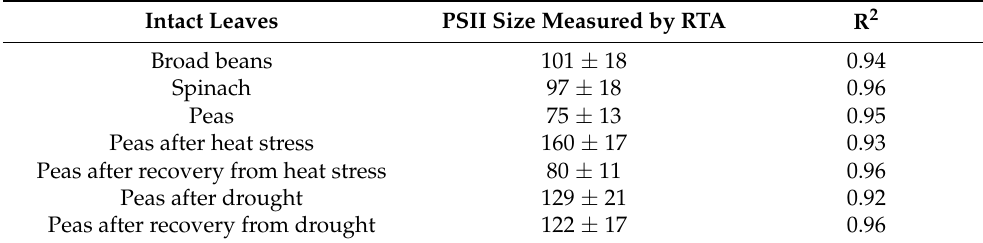
Table 4. Radiation target analyses (RTA) of intact seedlings leaves. In control experiments, there was no change in the F v /F m fluorescence ratio in leaves kept at the same low temperature and conditions. Functional molecular sizes (kDa) of PSII were determined by the Beauregard and Potier relationship [32]. The experiments were repeated four times. R: linear correlation coefficient. Intact Leaves PSII Size Measured by RTA R 2 Broad beans 101 ± 18 0.94 Spinach 97 ± 18 0.96 Peas 75 ± 13 0.95 Peas after heat stress 160 ± 17 0.93 80 ±